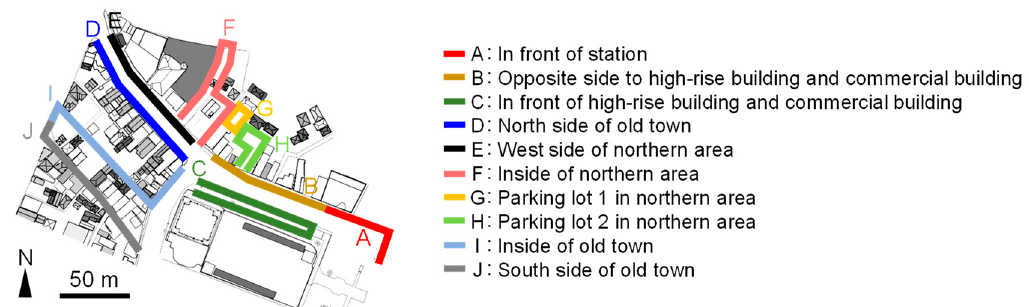
Figure 6. Division of mobile observation route into sections.